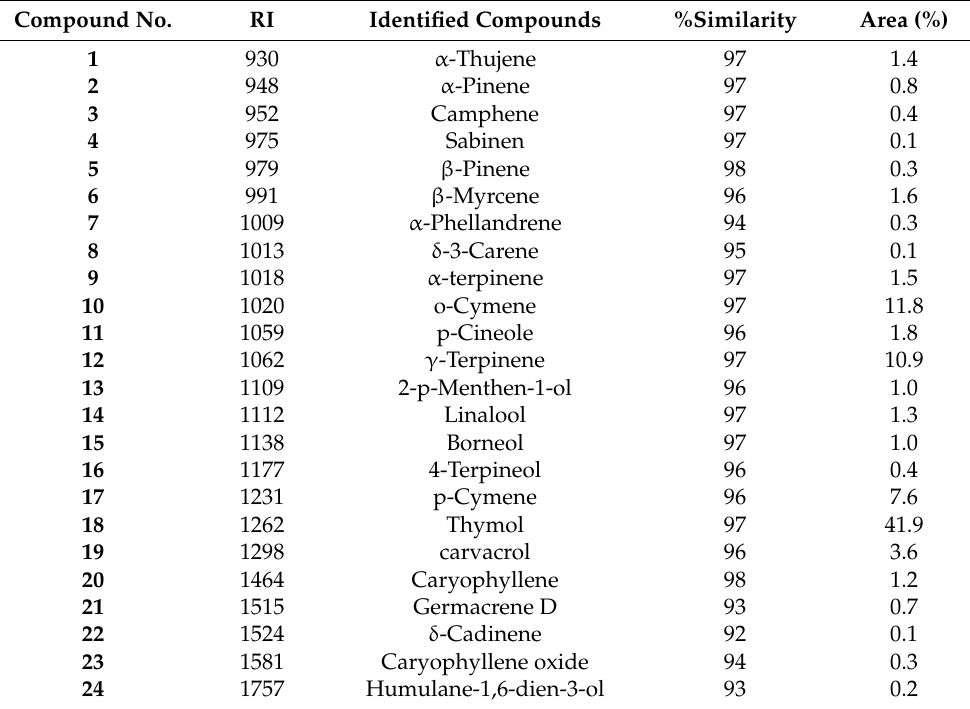
Table 4. Composition of the T. Vulgaris essential oil extract according to the GC-MS analysis. Compound